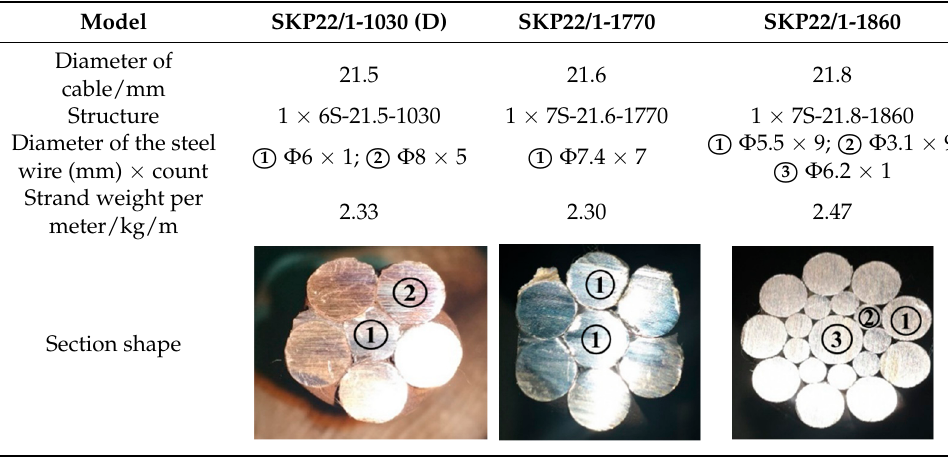
Table 1. The cable type and structure characteristics.